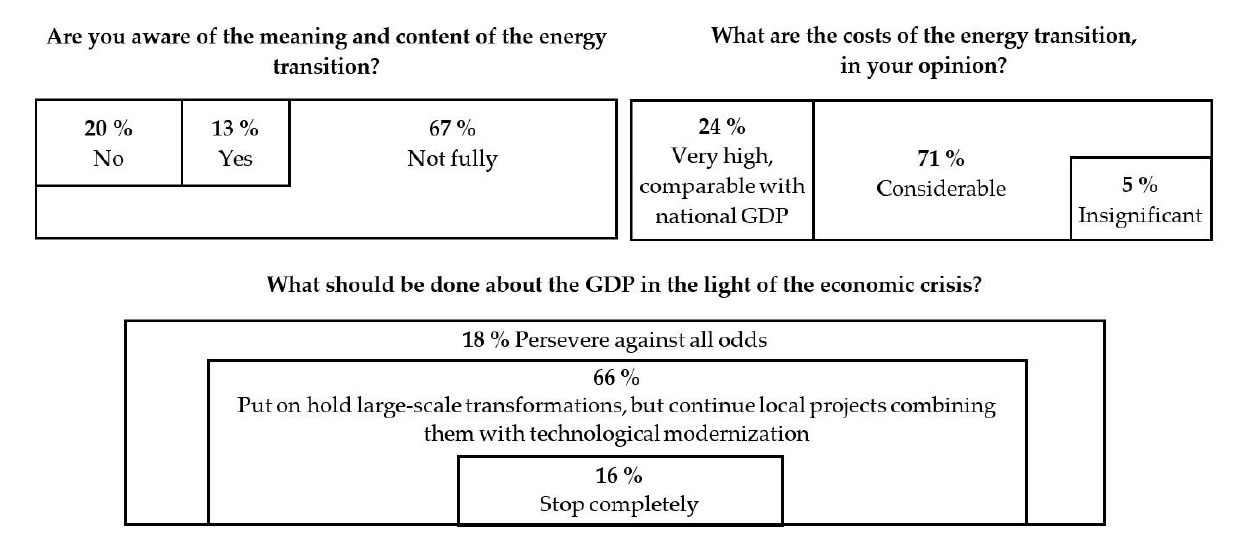
Figure 7. Experts ’ opinions on the nature, costs, and feasibility of energy transition measures in the time of economic recession.